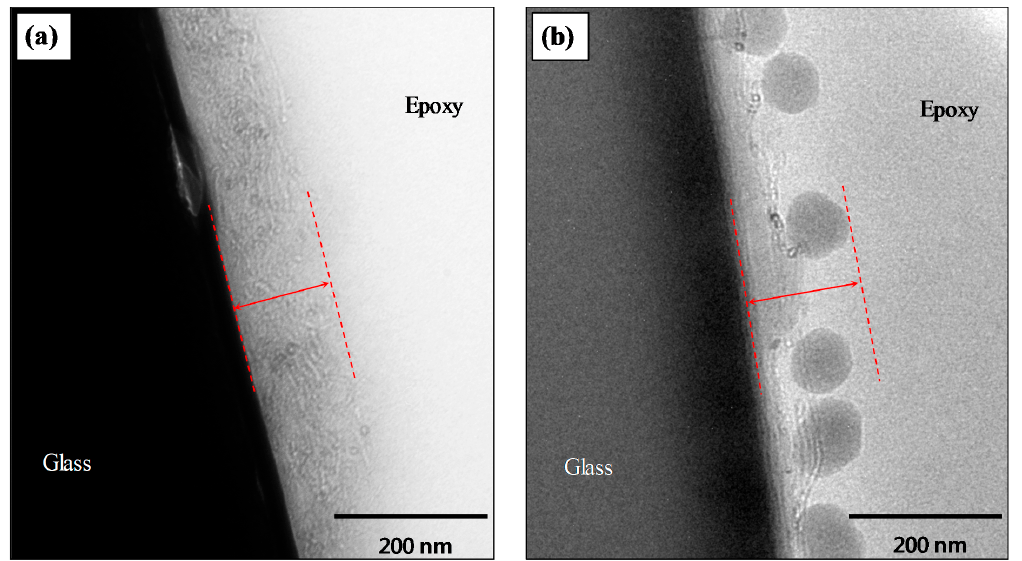
Figure 6. TEM images showing the interphase microstructure of ( a ) GF-CNT and ( b ) GF-CNT/SiO 2 single fiber model composites (dashed lines illustrate the nanostructured interfacial region thickness of approx. 120–150 nm).